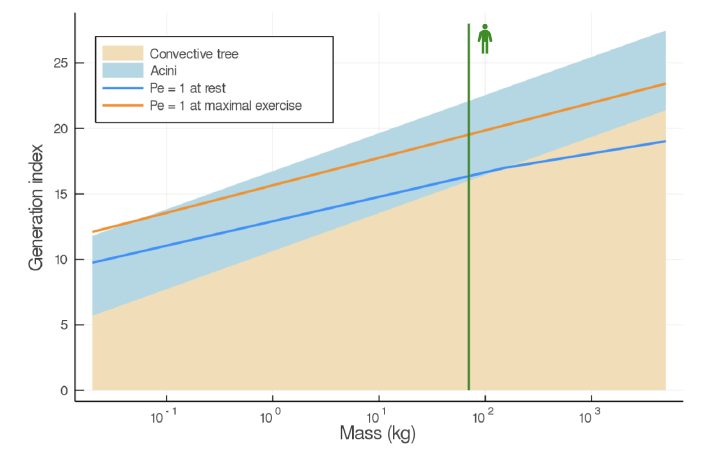
Figure 3 – Localization of the transition between convective and diffusive transport of oxygen in the lung as a function of animal mass (logarithmic scale). The lines correspond to the localizations of that transition at BMR (rest, blue line) and MMR ( line). The vertical green line corresponds to human mass ( 70 kg). The lower beige re- gion corresponds to the convective zone of the lung and the upper blue region corre- sponds to the exchange surface (acini). Small mammals tend to transport oxygen mainly by convection. Hence, there is no screening effect (Sapoval et al., 2002) affecting their exchange surface. Their oxygen pressure gradients between alveoli and blood are maxi- mal everywhere, making their pulmonary system very efficient. To the contrary, due to the screening effect, large mammals use only a small portion of their exchange surface at rest. Hence, large mammals have a large reserve of exchange surface available for higher metabolic rates. Increasing the ventilation amplitude decreases the screening ef- fect. Hence, the pulmonary system of large mammals is more efficient at exercise than at